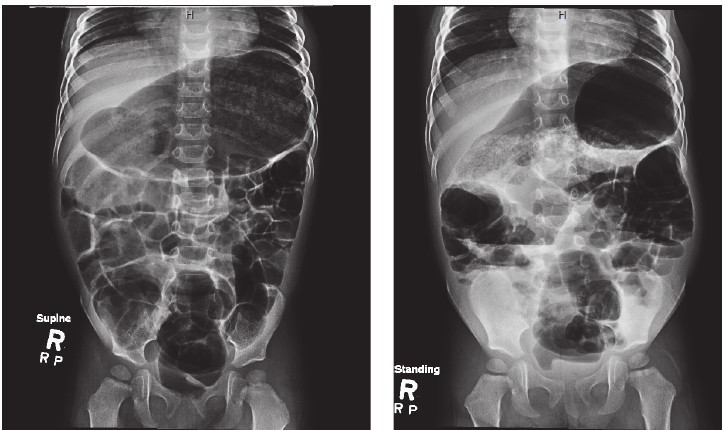
Figure 2: Supine and upright plain X-rays of the patient presented in Case 1. Moderate dilatation of the bowel is seen with significant gaseous distention of the stomach being seen. Multiple air-fluid levels are seen. No free intra-abdominal air is